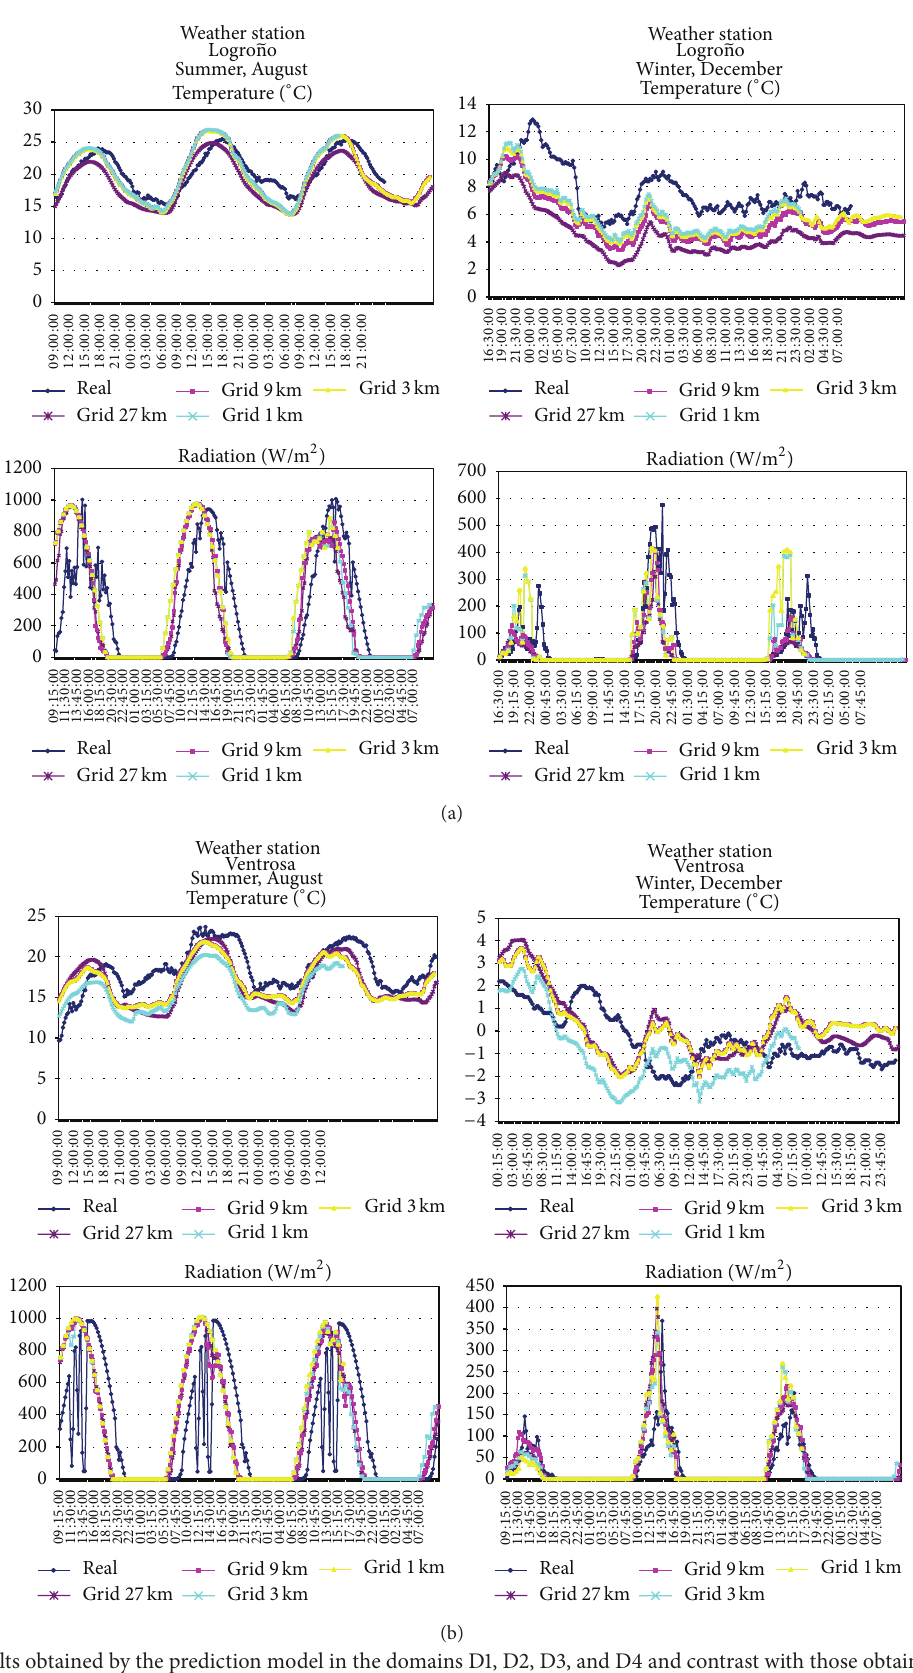
Figure 5: (a) Results obtained by the prediction model in the domains D1, D2, D3, and D4 and contrast with those obtained at the Logro˜no weather stations. (b) Results obtained by the prediction model in the domains D1, D2, D3, and D4 and contrast with those obtained at the Ventrosa weather